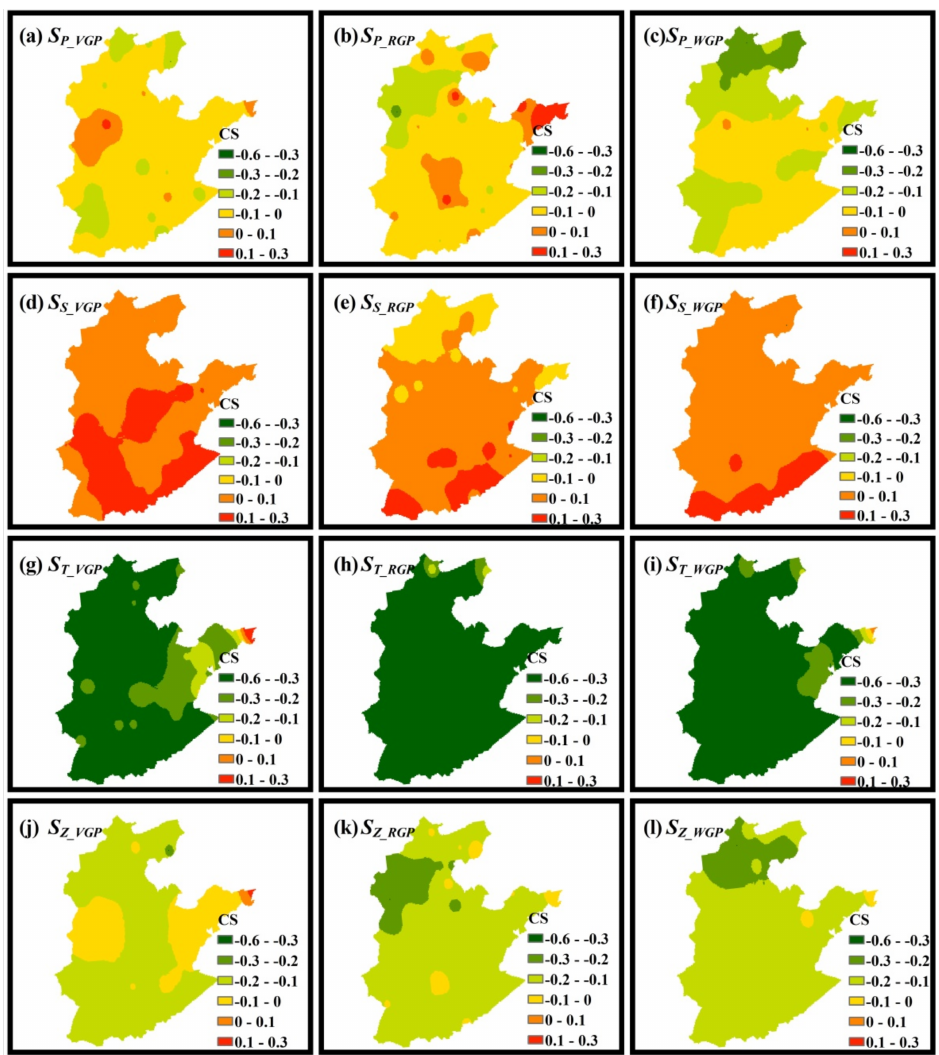
Figure 6. The spatial distribution of change of maize climate suitability for the vegetative growth period ( a , d , g , j ), reproductive growth period ( b , e , h , k ) and whole growth period ( c , f , i , l ) under SSP585 during the 2080s compared to the baseline period (1981–2010) in the North China